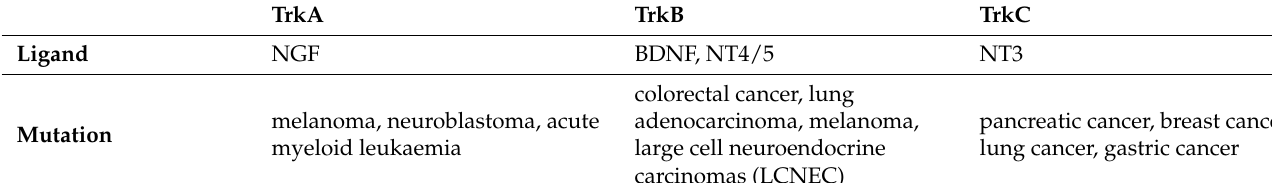
Table 1. Ligands and gene alterations of Trk family in various